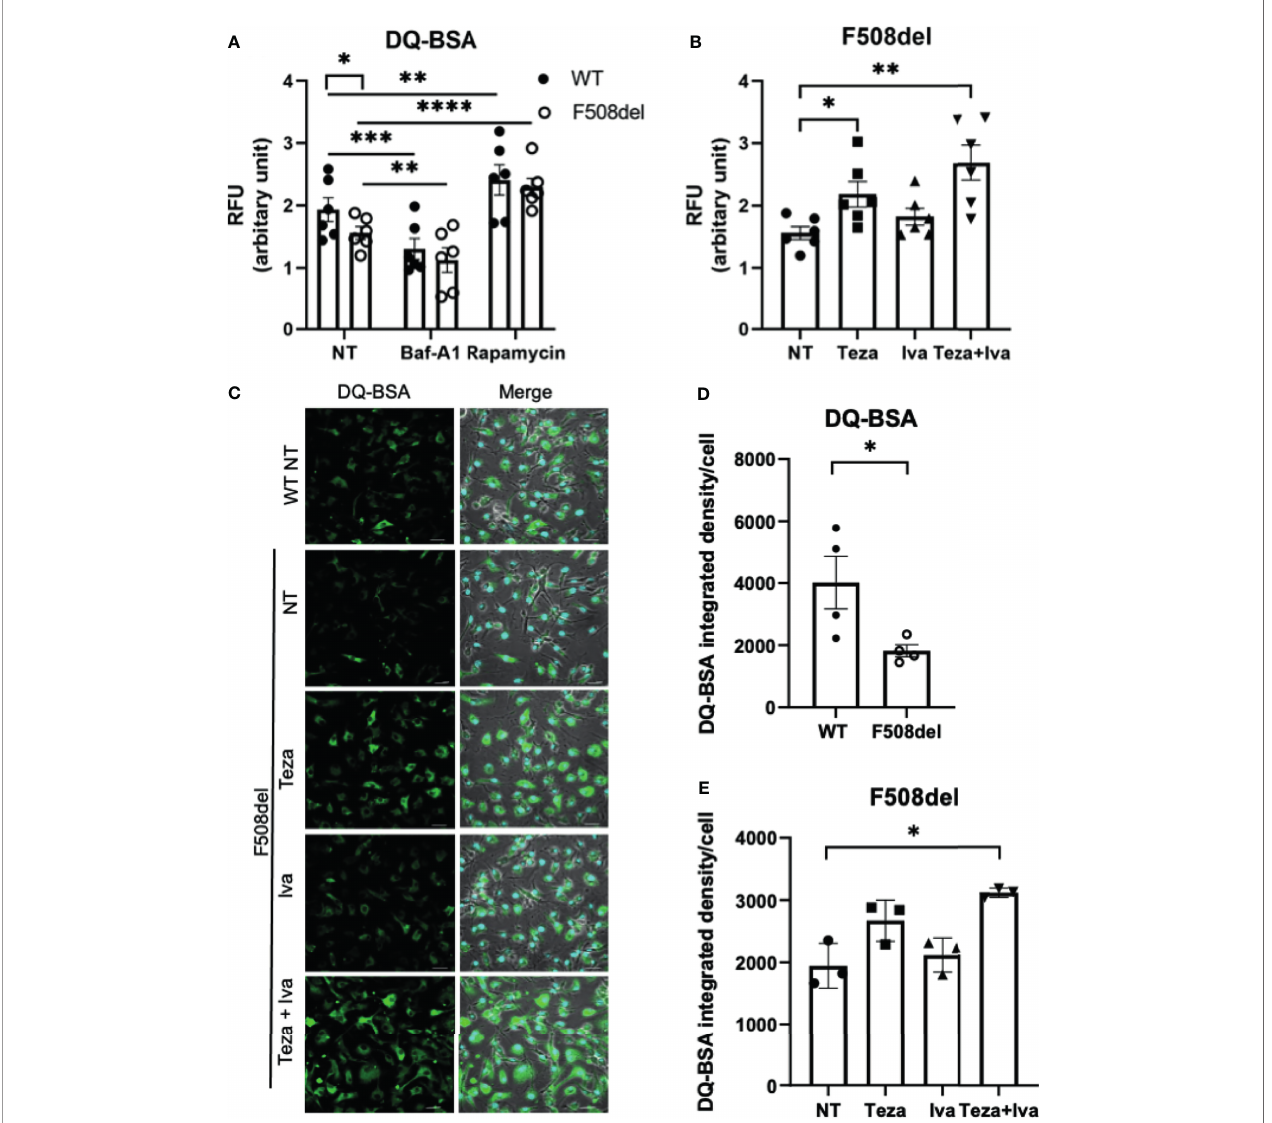
FIGURE 3 | Lysosomal degradative function in F508del macrophages is defective and improves in response to CFTR modulators. (A) DQ-BSA fl uorescence in wild- type (WT) and F508del macrophages, non-infected (NT), treated with 100 nM of Baf-A1 for 2 h, or with 5 µg/ml of rapamycin for 24 h. Data show mean fl uorescence intensity (MFI) normalized to the total number of cells. Data represent mean ± SEM (n = 6 biological replicates). Statistical analysis was using two-way ANOVA; *, p ≤ 0.05; **, p ≤ 0.01; ***, p ≤ 0.001; * ***, p ≤ 0.0001. (B) DQ-BSA fl uorescence in F508del macrophages NT (plotted in A or treated with 10 µM of Teza − /+ 5 µM of Iva for 24 h. Data represent MFI normalized to the total number of cells. Data represent mean ± SEM (n = 6 biological replicates). Statistical analysis was done using one-way ANOVA; *, p ≤ 0.05; **, p ≤ 0.01. (C) Representative confocal microscopy images of DQ-BSA staining of WT, and F508del macrophages, NT, or treated with the indicated CFTR modulators (n = 3 biological replicates); scale bar = 20 µm. Merged images showing phase contrast, DAPI, and DQ-BSA channels. (D, E) DQ-BSA fl uorescence integrated density calculated from images in (C) normalized to the total number of cells. Data represent mean ± SEM calculated using ImageJ software from randomly chosen fi elds of view with an average of 50 cells per fi eld from 3 independent experiments. Statistical analysis was done using paired t-test (D) and one-way ANOVA (E) ; *, p ≤